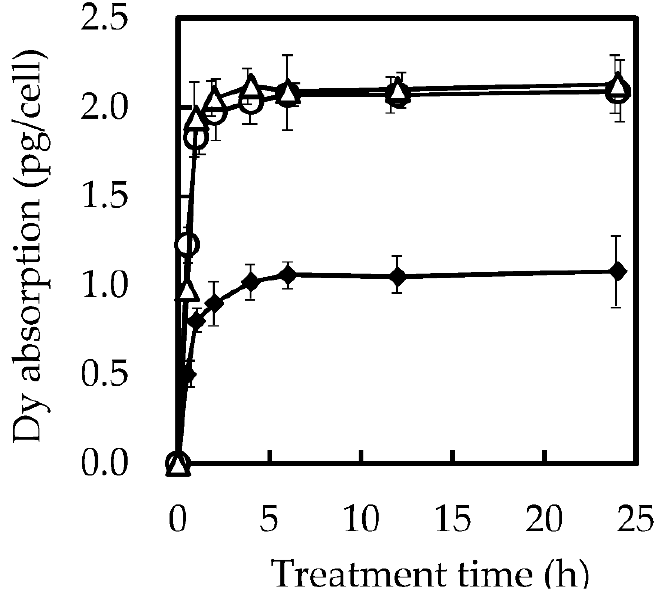
Figure 2. Profiles of Dy absorption based on exposure time. Filled diamonds are S. cerevisiae BY4741. Open circles and triangles are Al-absorbing strains Alt-OF2 and Alt-OF5, respectively.